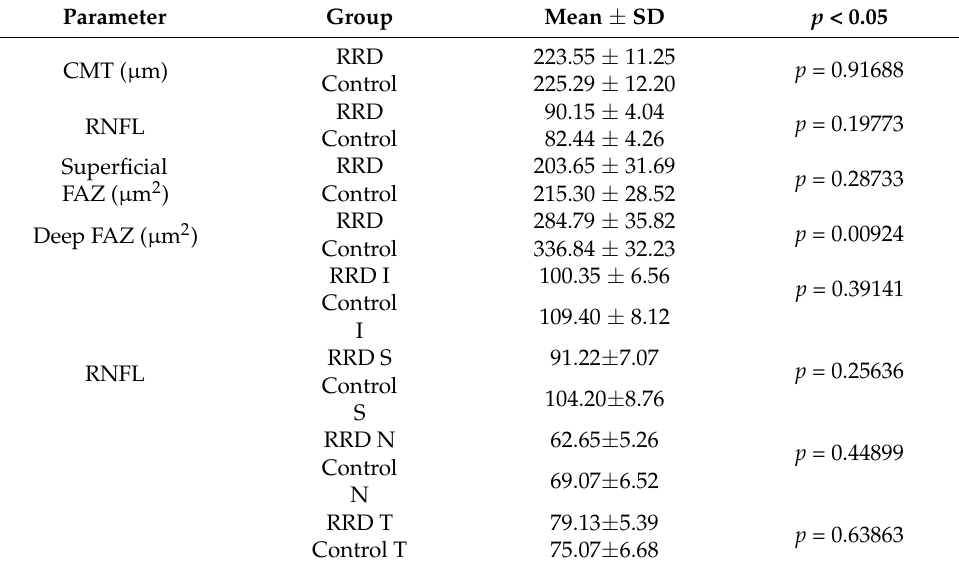
Table 2. Comparison of tomographic results between the